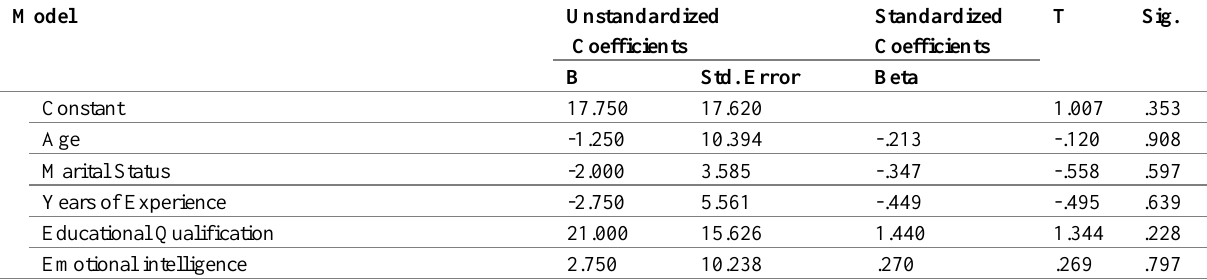
Table 9: Regression Analysis Showing the Relationship between Demographic Variables and Emotional Intelligence